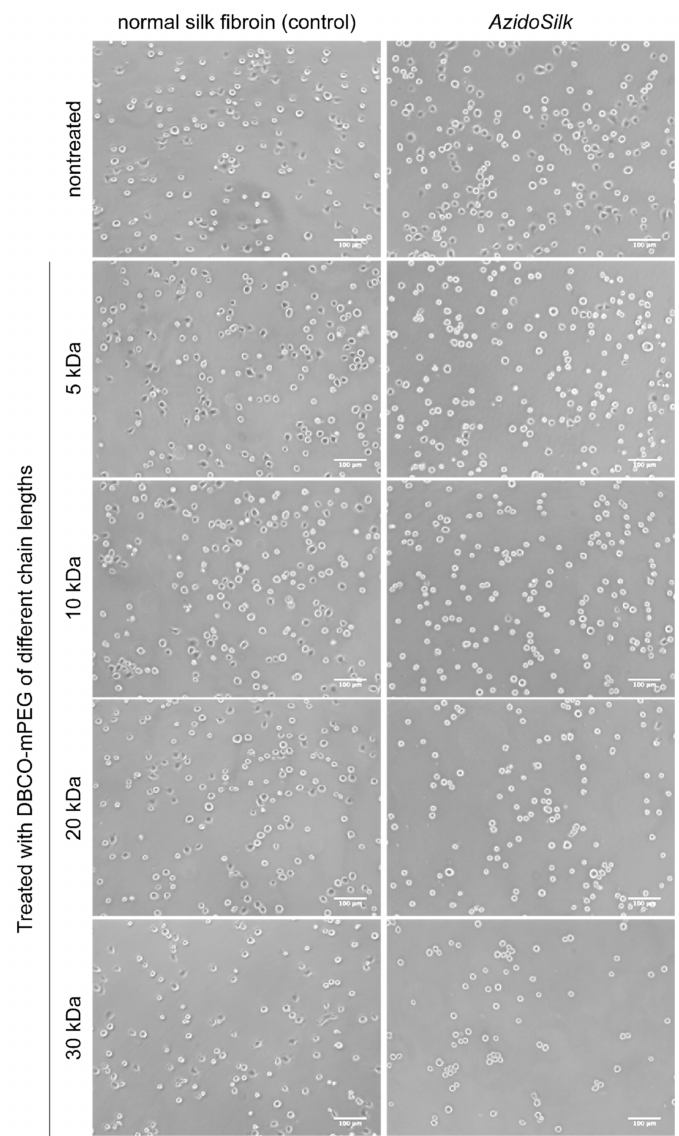
Figure 3. Adhesion of NIH3T3 fibroblasts on the surfaces of normal silk fibroin and AzidoSilk film when treated with DBCO-mPEG of di ff erent chain lengths (5, 10, 20, and 30 kDa). Pictures were taken after 2 h culture at 37 ◦ C in Eagle minimum essential media (MEM) without fetal bovine serum (FBS). Scale bars are 100 µ